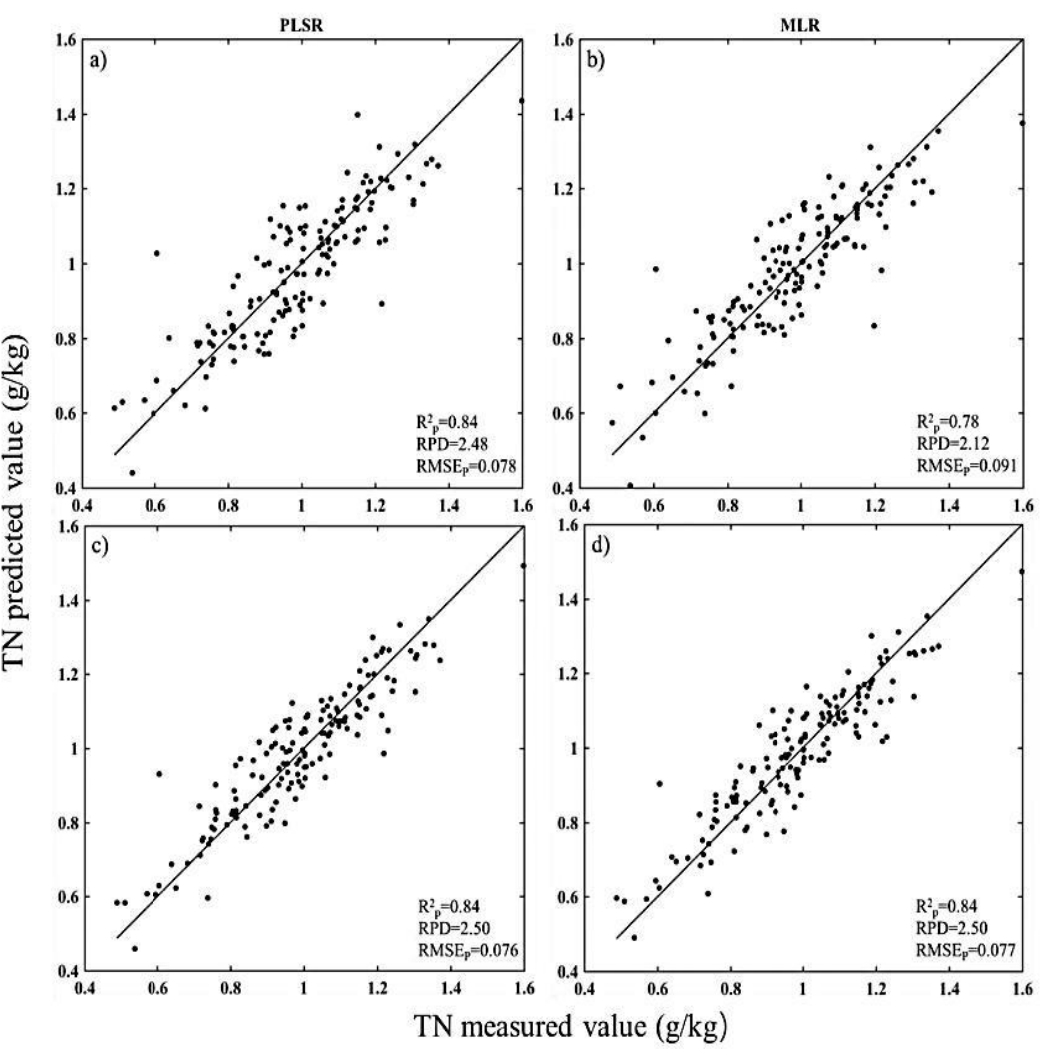
Figure 9. Scatter plots of the measured versus predicted TN contents using different models with various modelling strategies: ( a ) BOSS-PLSR; ( b ) BOSS-MLR; ( c ) sCARS-PLSR; ( d ) sCARS-MLR.